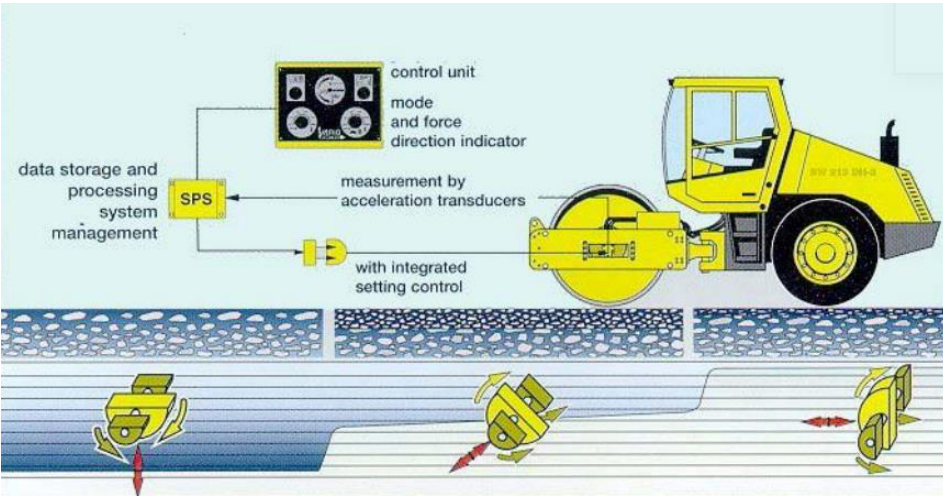
Figure 5. Schematic of BOMAG compactor used for the IC demonstration at MnROAD [42]. The circular facility of the University of Los Andes in Colombia investigated various techniques used in soil stabilization using accelerated pavement testing [40]. In